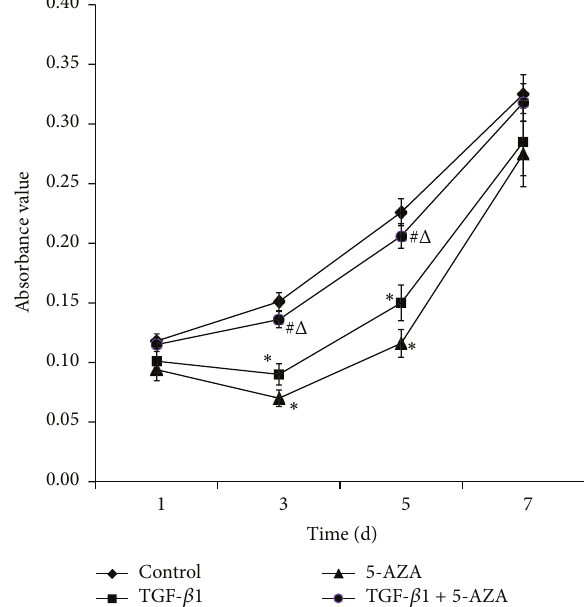
Figure 2: Cells proliferation in different groups. The 𝑥 -axis repre- sents time, while the 𝑦 -axis represents the absorption values. Results are expressed as means ± SEM. ∗ 𝑃 < 0.05 versus control group; # 𝑃 < 0.05 versus TGF- 𝛽 1 group; Δ 𝑃 < 0.05 versus 5-AZA group ( 𝑛 = 6